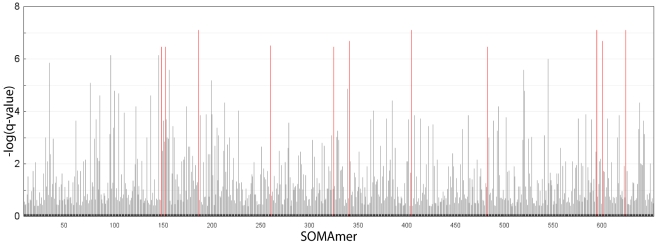
Biomarker discovery in CKD.Distribution of the false discovery rate (q-value) for the Mann-Whitney test statistic comparing late-stage vs. early-stage CKD for each protein measured (indicated as a bar on the x-axis) ordered arbitrarily.